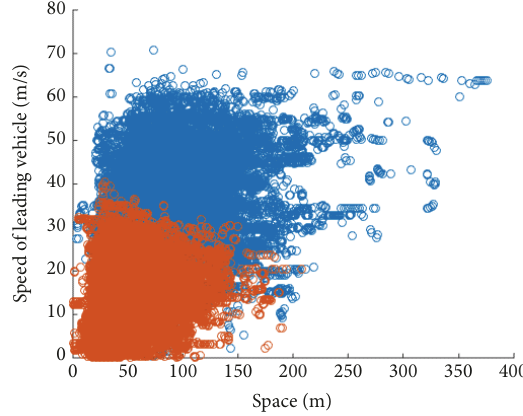
Figure 1: Clustering results of traffic